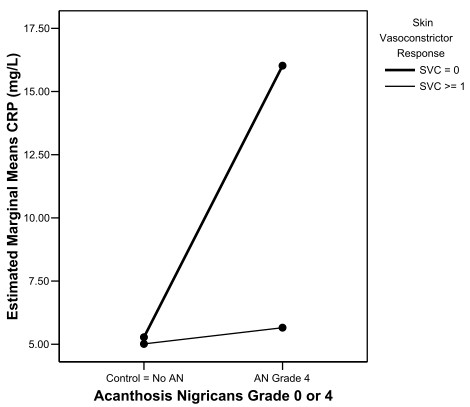
Model estimated marginal means of C-reactive protein at different levels of skin vasoconstrictor response to topical beclomethasone dipropionate(SVC). SVC is classified as not present at all (= 0) or present (> = 1) for patients with and without acanthosis nigricans [Study 1].